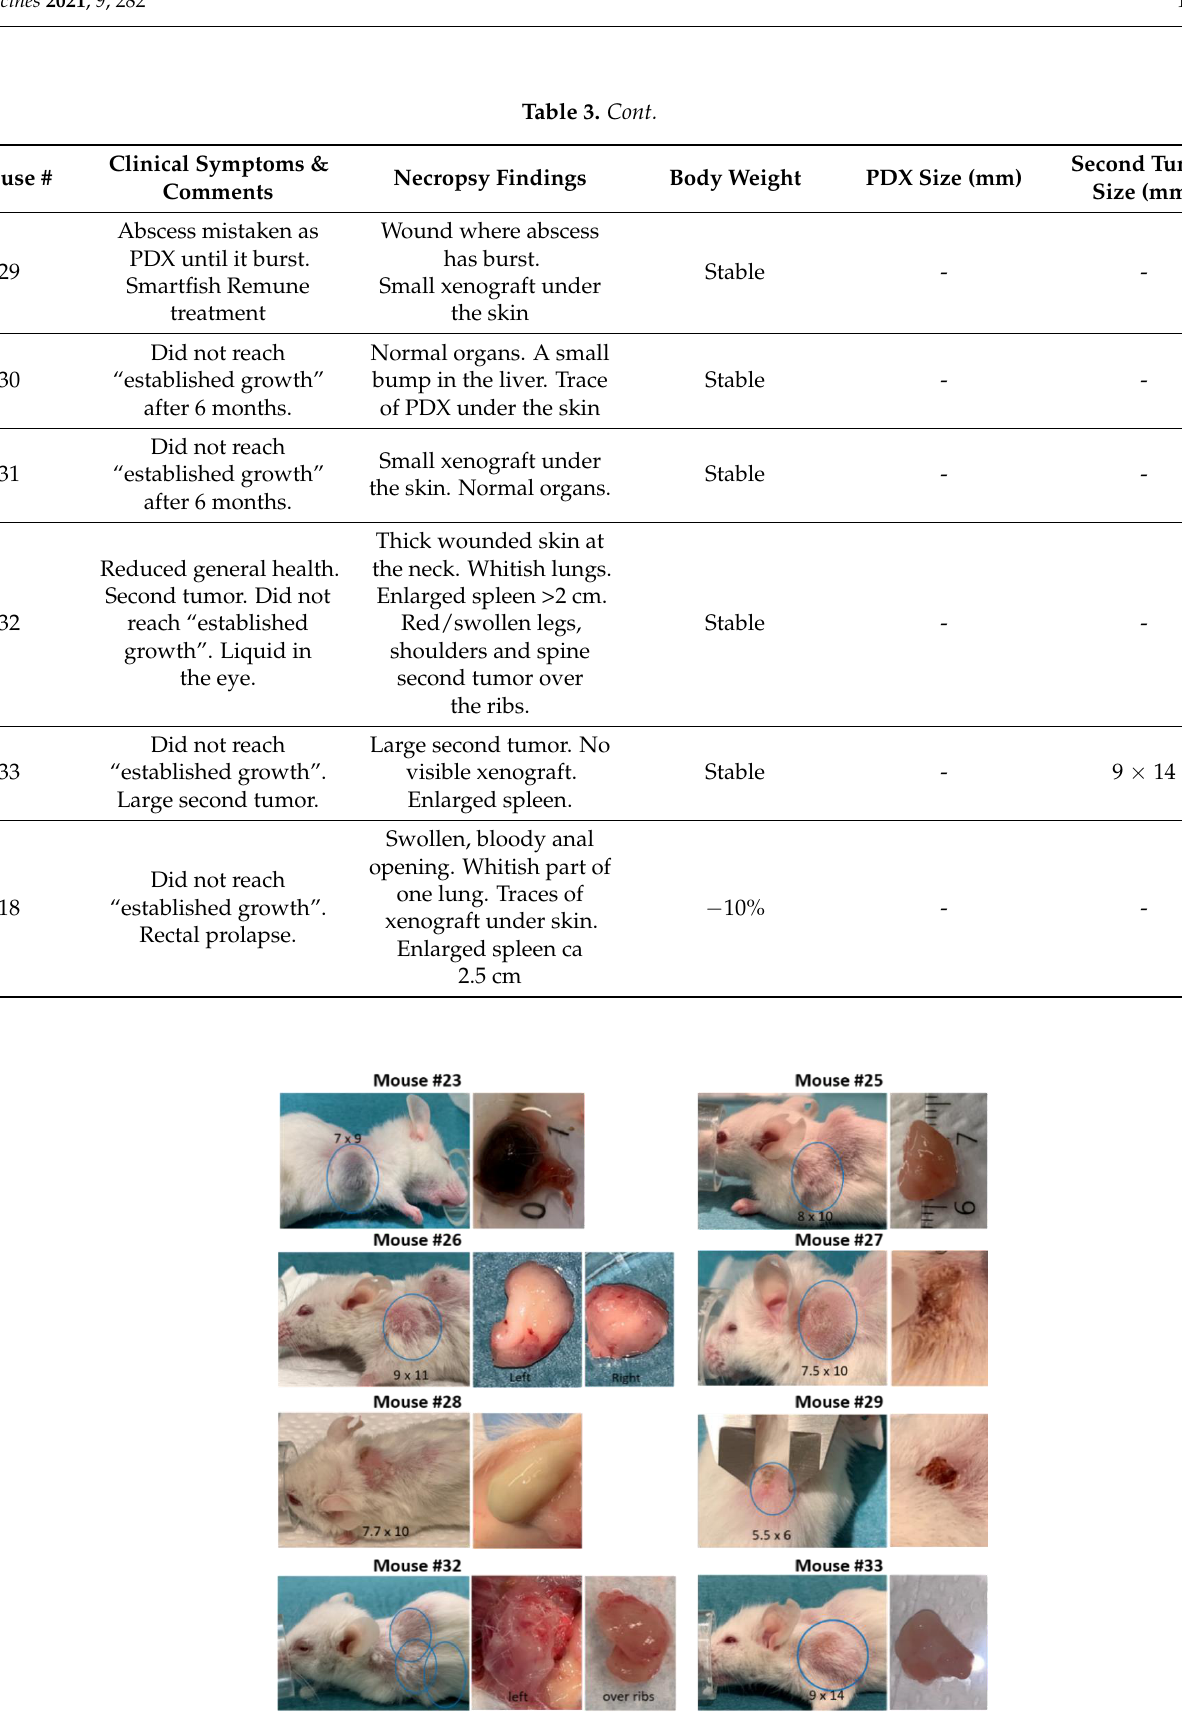
Figure 11. Pictures of mice developing secondary tumors (mouse #23, 25, 26, 32 and 33) or abscesses (mouse #27, 28 and 29). Numbers represent tumor size in mm.